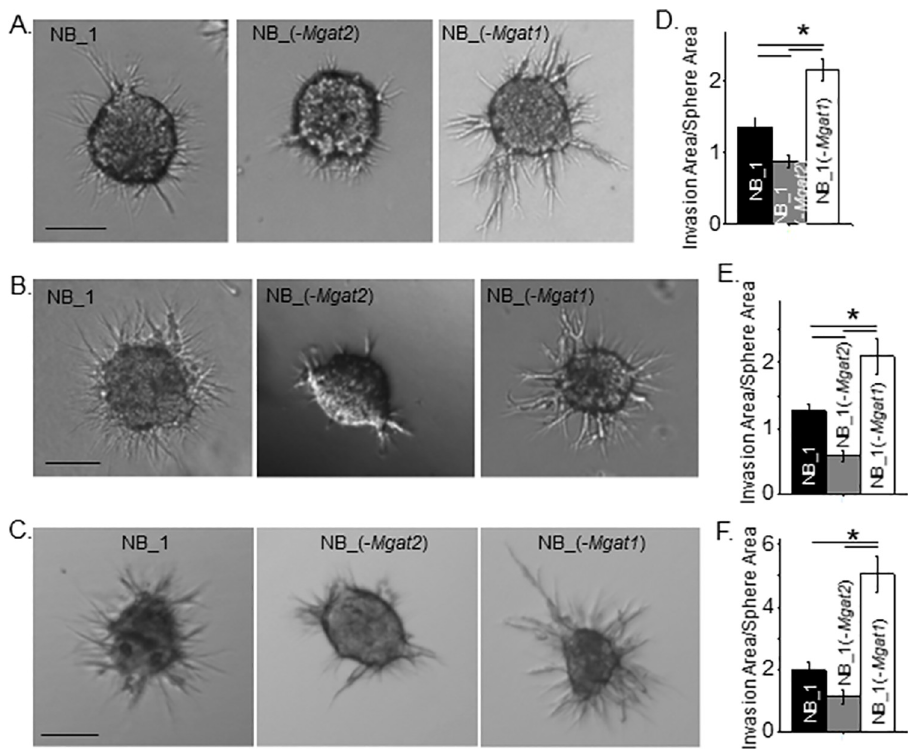
Fig 6. NB cell invasion is independent of spheroid cell size and dependent on incubation period of spheroid cells. Characteristic images of invading spheroid cells from those cultured for 4 (A) and 6 (B) days of NB_1 ( n = 45 and 43), NB_1(- Mgat2 ) ( n = 49 and 26) and NB_1(- Mgat1 ) ( n = 59 and 48) cell lines and incubated in Matrigel matrix for 16 h duration, and spheroid cells cultured for 6 days (C) and incubated in Matrigel matrix for 24 h duration of NB_1 ( n = 21), NB_1(- Mgat2 ) ( n = 23) and NB_1(- Mgat1 ) ( n = 20) cell lines. Scale bar denotes 25 μ m. Quantification of cell invasiveness of the various cell lines in which spheroids were cultured for 4 (D) and 6 (E and F) days and incubated in Matrigel matrix for 16 (D and E) and 24 (F) hours. Data are shown as the mean ± SEM and were compared by one-way ANOVA using Holm-Bonferroni post-hoc test ( � p < 0.05). n denotes number of invading spheroids. Pearson’s correlation coefficient determined from sphere area versus invasion area were the following: NB_1, 0.69; NB_1 (- Mgat2 ), 0.65; NB_1(- Mgat1 ), 0.75 from 4 day old spheroid allowed to invade for 16 h. Pearson’s correlation coefficients for the following: NB_1, 0.57; NB_1(- Mgat2 ), 0.62; NB_1(- Mgat1 ), 0.51, and NB_1, 0.68; NB_1(- Mgat2 ), 0.51; NB_1(- Mgat1 ), 0.79 from 6 day old spheroid allowed to invade for 16 h and 24 h, respectively. area for all three cell lines. Hence, cell invasiveness was modified by altering the N-glycosyla- tion pathway in NB cells.